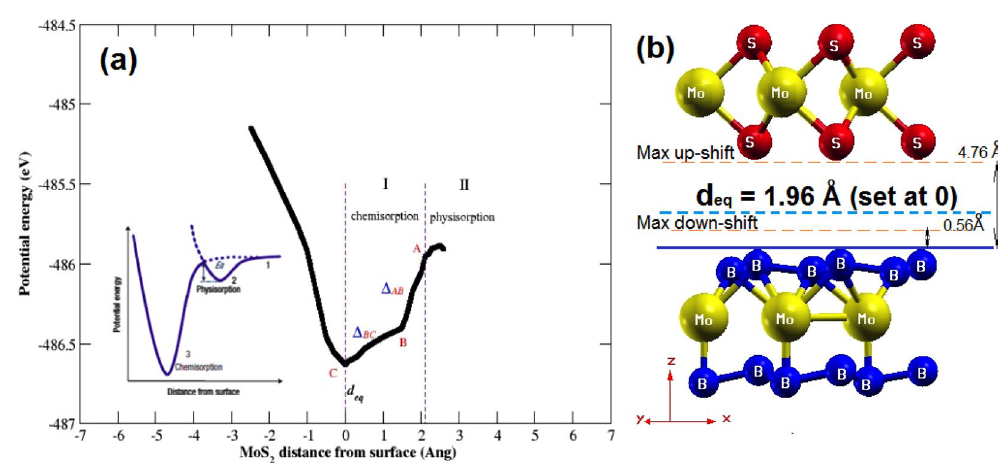
Figure 6. Nature of adsorption exists in the MoS 2 / MoB 2 HS. Inset figure shows the ideal curve of adsorption.